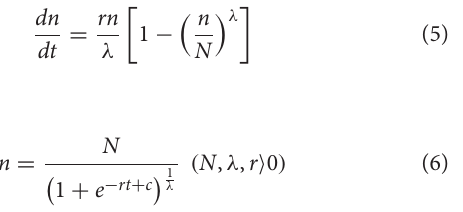
of cumulative cases to time, which represents the change rate